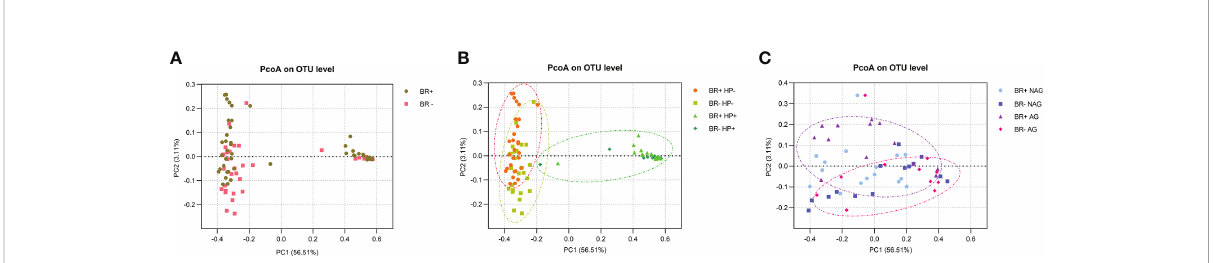
FIGURE 4 PcoA analysis of the gastric microbiota. (A) Comparison of the BR+ and BR- groups, (B) Comparison of the BR+ HP-, BR- HP-, BR+ HP+ and BR- HP+ groups; orange circle, a gastric sample from the BR+ HP- group; yellow circle, a gastric sample from the BR- HP- group; green circle,